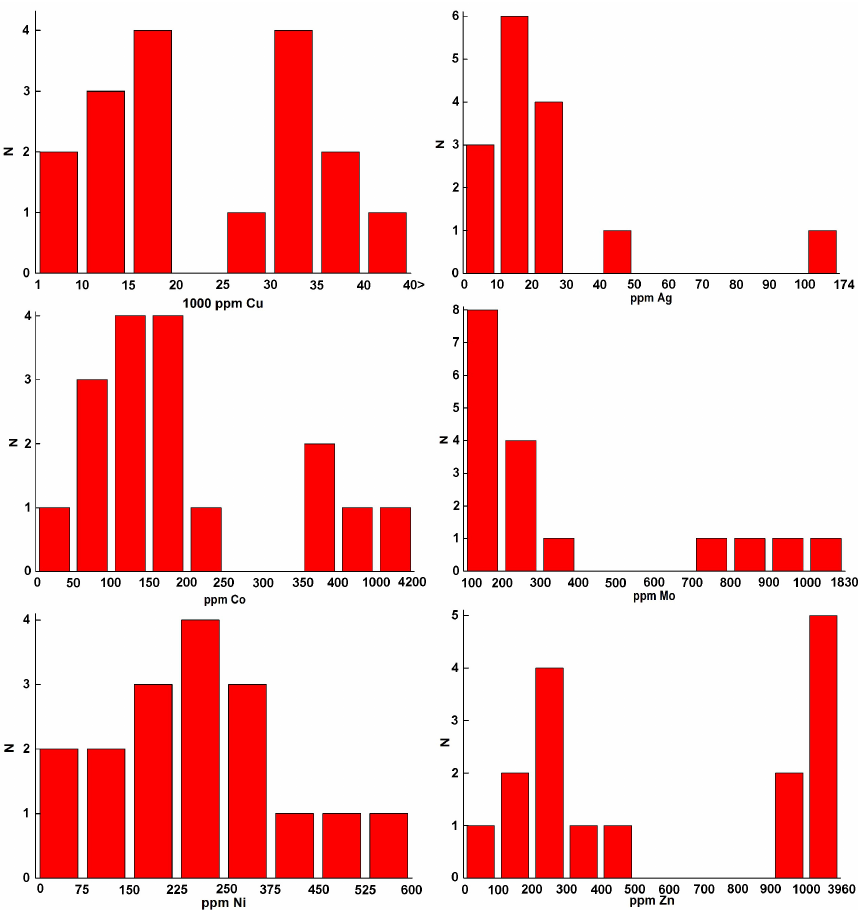
Figure 22. Histograms of the distributions of the Cu-Co-Ni-Ag-Mo-Zn contents by frequency of occurrence based on analyses of homogenized melt sulfide inclusions.